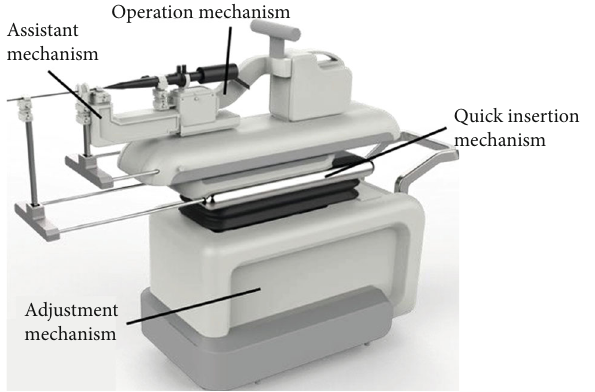
Figure 10: The integration of the slave manipulator. Table 2: Design parameters of the proposed robotic system. Motion ranges